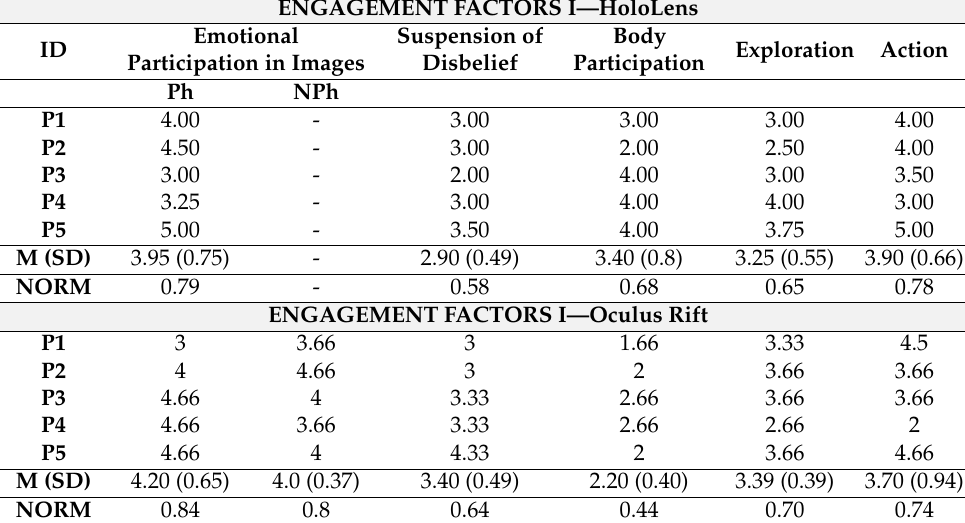
Table 7. Results for engagement factors I: mean (M) scores with standard deviation (SD) and normalized (NORM) mean